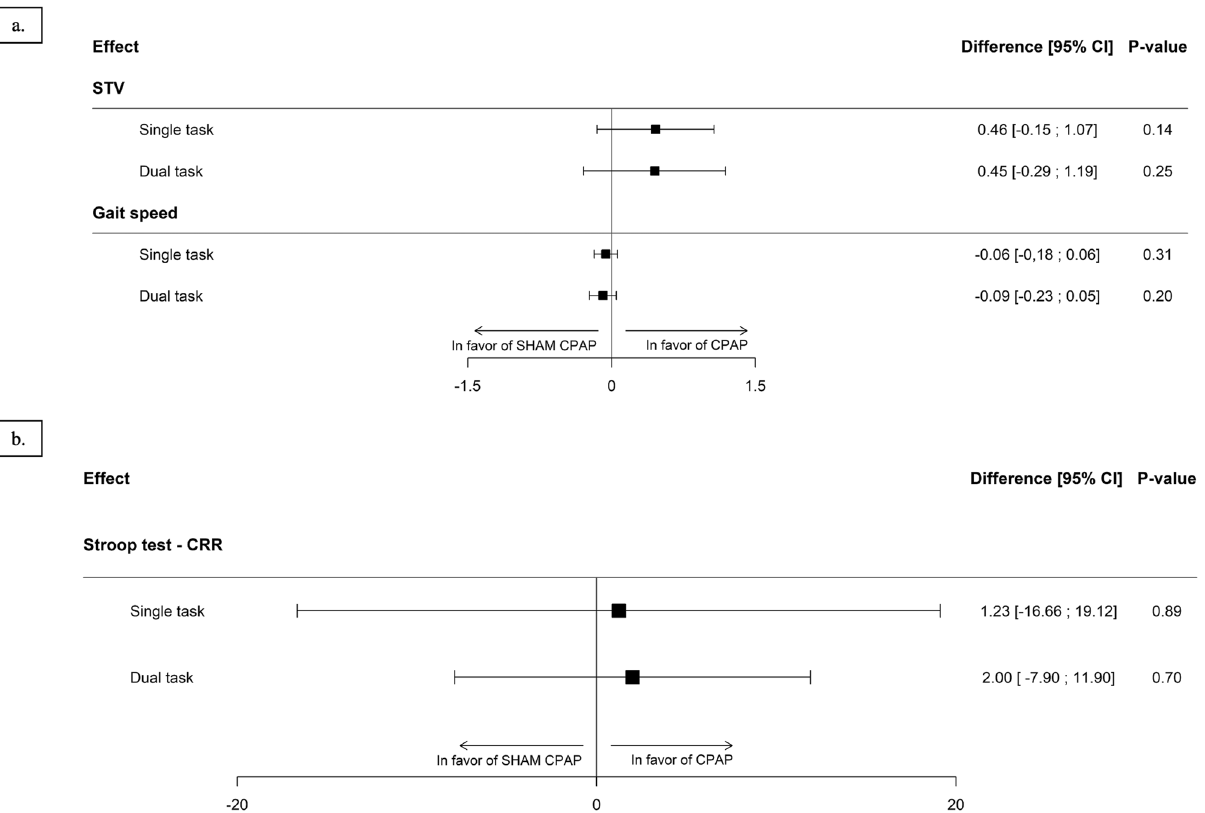
Figure 2. Effect of continuous positive airway pressure (CPAP) on gait control ( a ) and Stroop test performance ( b ) assessed in single (gait or Stroop test only) and dual task (gait and Stroop test performed simultaneously) (linear mixed effect model analysis). CPAP continuous positive airway pressure, CRR correct response rate, DT dual task, ST single task, STV stride time